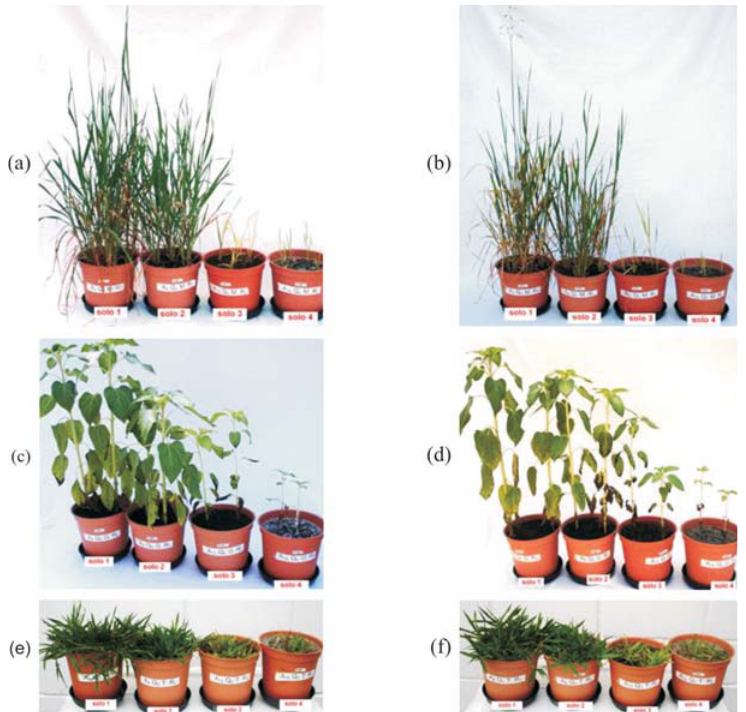
Figura 3. Aspectos visuais do crescimento das plantas sem quelante (a, c, e) e com quelante (b, d, f) após 71 dias de cultivo, com detalhe das plântulas com clorose intensa e dificuldade de crescimento nos solos 3 e 4. a, b: aveia-preta; c, d: girassol; e, f: grama-batatais.